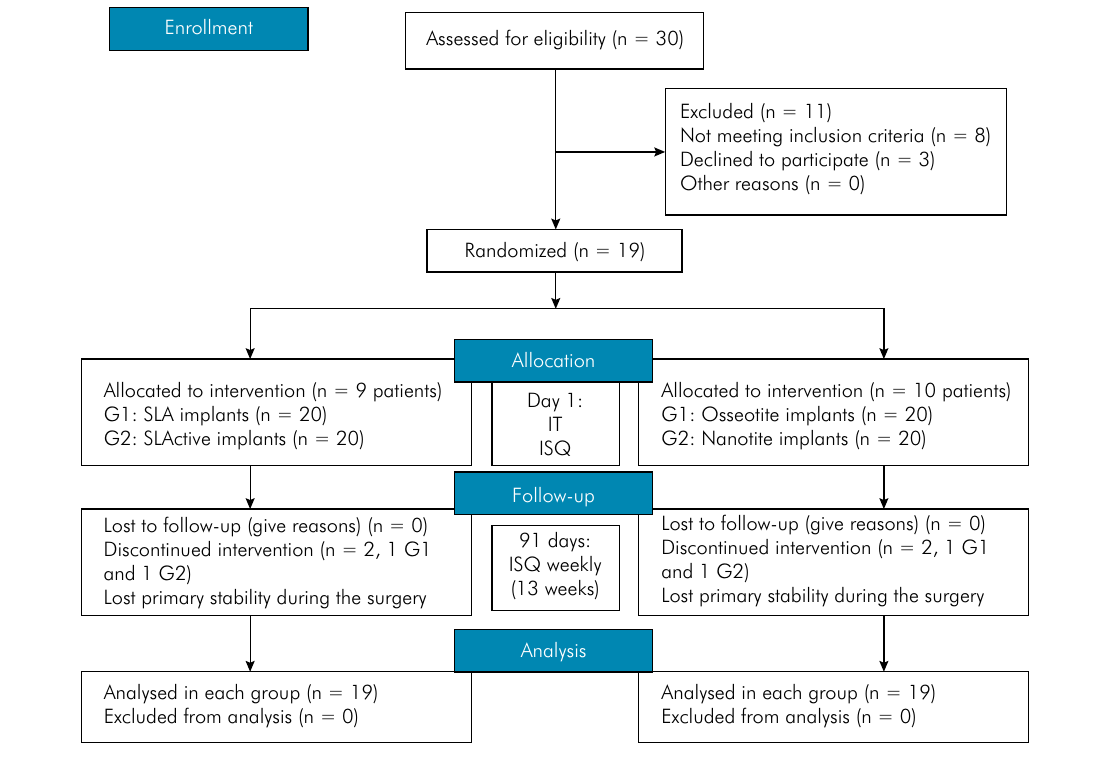
Figure 2. Consort flow